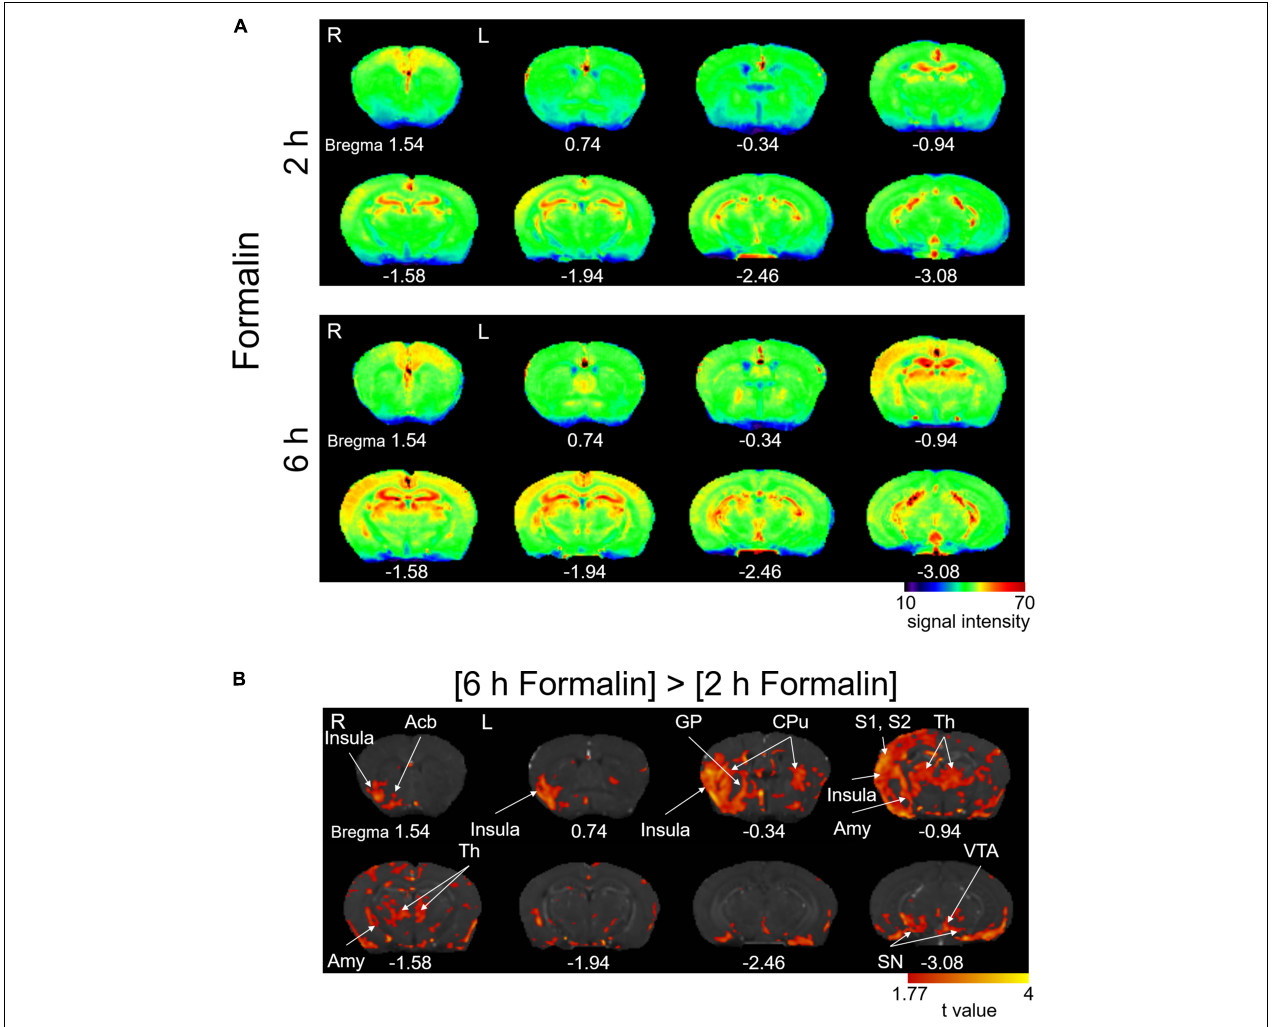
FIGURE 2 | Manganese accumulation in the brain after the freely moving post-formalin period. (A) Color map of averaged T1-weighted images in the [2 h Formalin] and [6 h Formalin] groups. R, the right side; L, the left side. The color bar indicates normalized signal intensity. The numbers below the images indicate the anterior-posterior coordinate from bregma. (B) Comparisons of the signal intensity between [2 h Formalin] and [6 h Formalin] shown as t -value plots ( P < 0.05, cluster-wise FDR corrected). Insula, insular cortex; Acb, nucleus accumbens; GP, globus pallidus; CPu, caudate putamen; S1/S2, primary/secondary somatosensory cortex; Th, thalamus; Amy, amygdala; SN, substantia nigra; VTA, ventral tegmental area. R, the right side; L, the left side. The color bar indicates the t